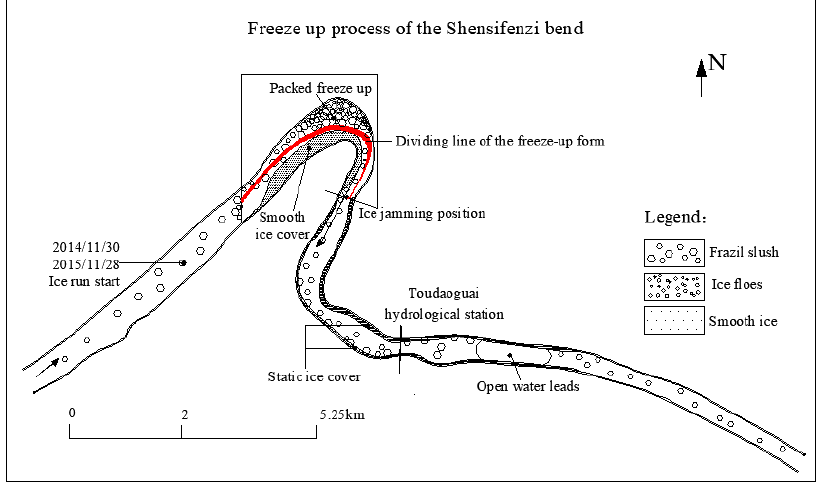
Figure 3. The freeze-up process of the Shensifenzi bend in the winter of 2014 and 2015. Ice formation process is characterized by heat flux, radiation, and friction with the bed and banks [21]. In this analysis supercooling event is going to be contemplated. Af- fected by the extremely cold air conditions, the temperature of the study area sharply de- creased, and concentrations of drifting ice appeared in the river. The secondary circulation flow in river bends has significant effects on the flow velocity distribution where the main stream of the channel slants to the outer bank. The surface ice accumulation has a signifi- cant positive correlation with water and air temperature differences [22]. During the freeze-up period, the water temperature is below 0 °C, and the air temperature is mostly negative, so the relationship between air temperature and surface ice accumulation shows a negative correlation.